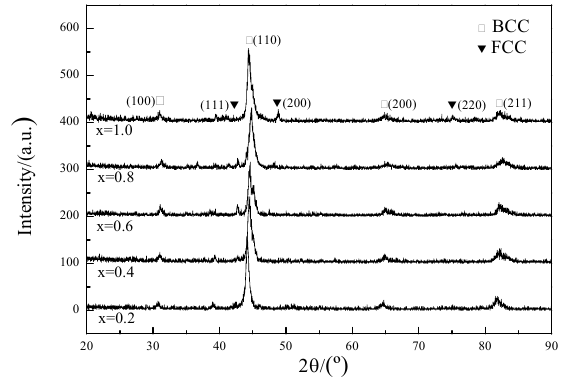
Figure 2. XRD results of AlCrFeNiSix high-entropy alloy.